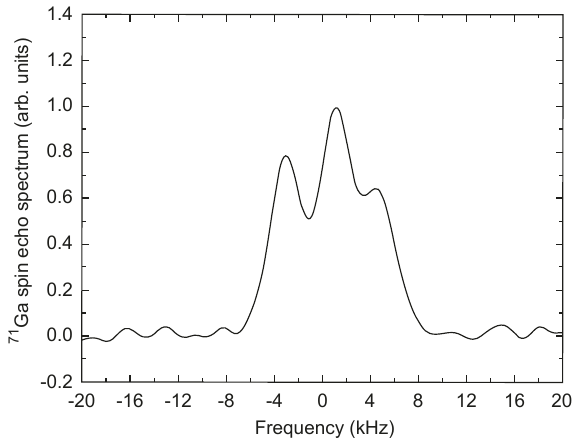
Fig. 4 71 Ga NMR spectrum measured under light illumination. NMR spectrum of the 71 Ga nuclei measured under light illumination with an intensity of 346 mW cm − 2 . In addition to the central transition line, two satellites are observed, and from the interval between them, the nuclear quadrupolar coupling ð ν Q Þ of approxi- mately 3.8 kHz is determined. The value of ν Q coincides with twice the inverse of the echo modulation period (530 μ s) obtained from the fi ttings of the modulated decays shown in Fig. 3b and c using Eq. (2), indicating that the echo modulation is caused by the quadrupolar coupling. The imbalance between the two satellites is due to the low nuclear spin temperature caused by the cooling effect of the optical pumping. Note that the ratio of the intensities between the central transition and the two satellites does not re fl ect the transition probabilities, owing to the different quadrupolar modulations 13